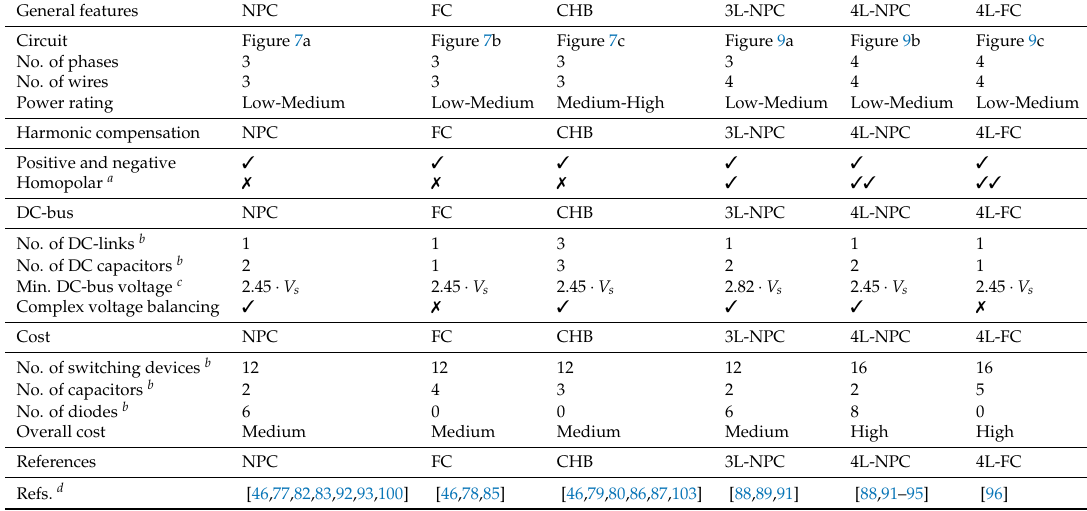
Table 9. Comparison of shunt multilevel APF